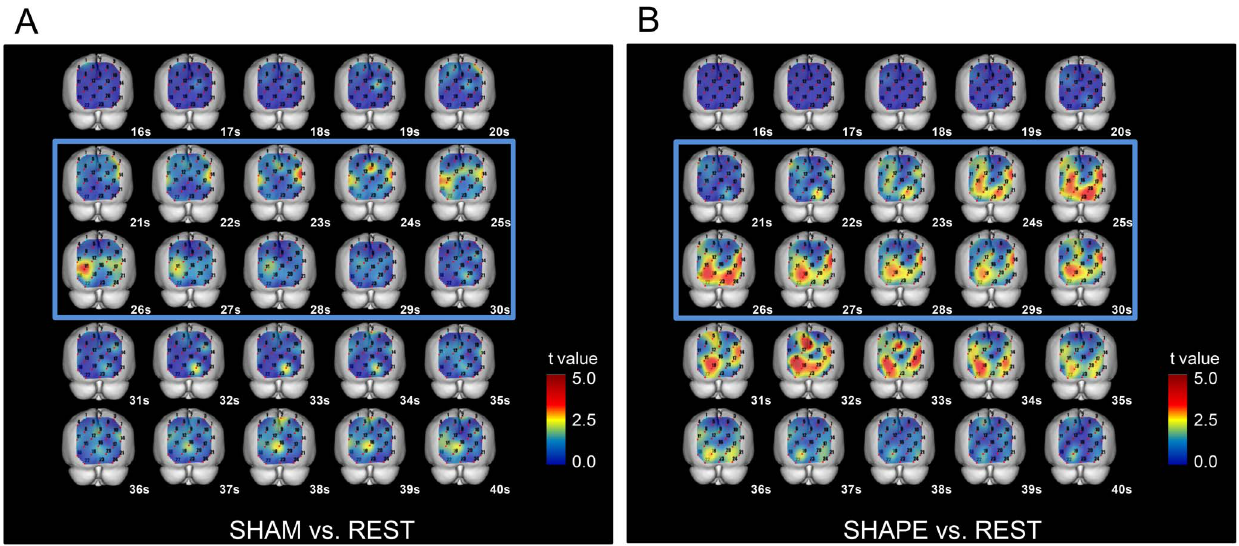
Figure 4. Cross-sectional statistical topographies showing differences in change in oxygenated hemoglobin concentration ([oxy- Hb]). A. Comparison between SHAM and REST sessions. The values for [oxy-Hb] during the task and post-task periods of the SHAM session were slightly but significantly increased (p , 0.05, paired t-test) as compared to those of the REST session in the posterior parietal cortex (BA7), extrastriate cortex (BA18, 19), and primary visual cortex (BA17). B. Comparison between SHAPE and REST sessions. The values for [oxy-Hb] during the task and post-task periods of the SHAPE session were significantly increased (p , 0.05, paired t-test) as compared to those of the REST session in the somatosensory association cortex (BA7), extrastriate cortex (BA18, 19), and striate cortex